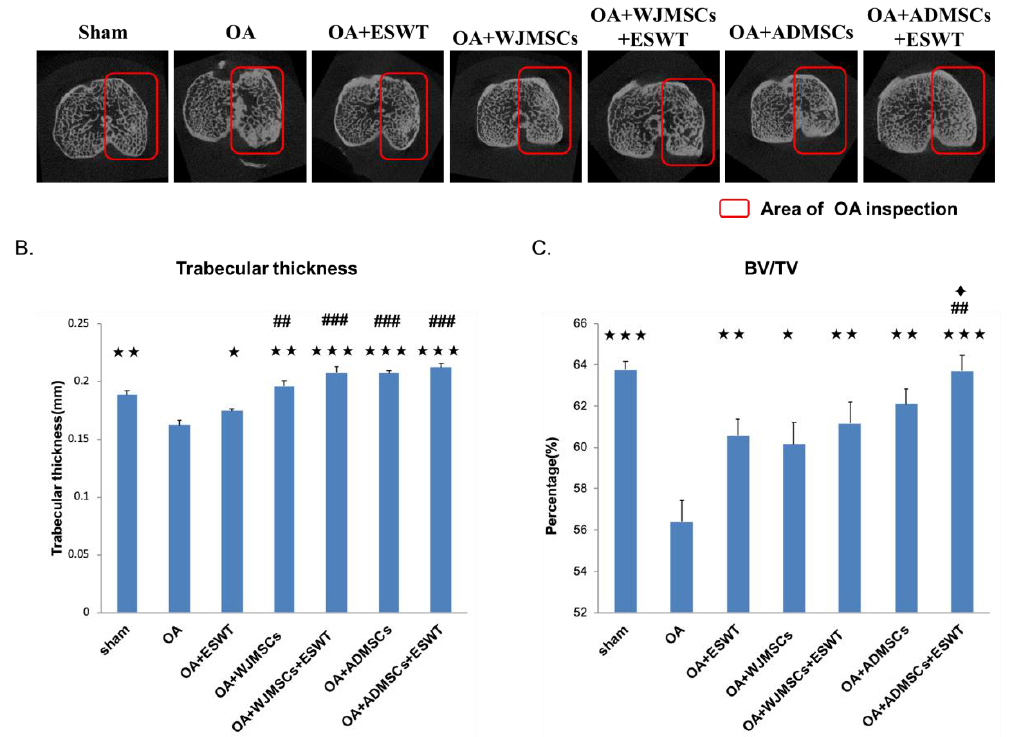
Figure 3. Micro-CT scans of the proximal tibia in different groups. ( A ) Photomicrographs of the knee in the sagittal and transverse views by micro-CT. The subchondral bone medial compartment of each group is marked by a red box. ( B ) Data resulting in graphic illustrations of trabecular thickness and ( C ) percentage of trabecular bone volume fraction (BV/TV) in the different groups. * p < 0.05, ** p < 0.01, and *** p < 0.001 were compared with OA; ## p < 0.01, and ### p < 0.001 were compared among treatment groups. ✦ p < 0.05 was compared ESWT combined with ADMSCs or WJMSCs each other. n = 6 for all groups.